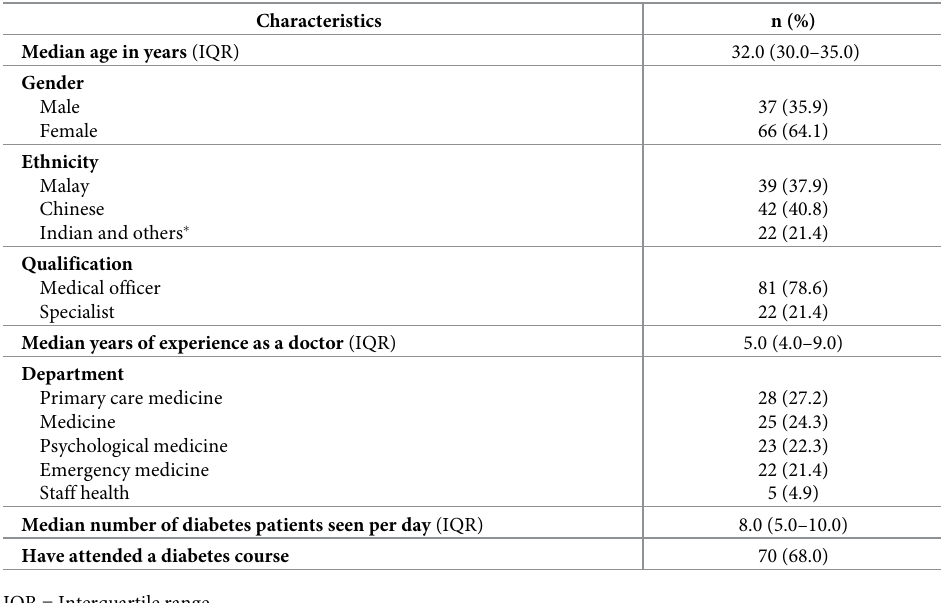
Table 1. Demographic characteristics of participants (n =